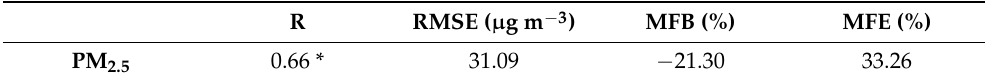
Table 4. Statistical metrics of the comparisons from hourly observed and simulated surface PM 2.5 concentrations at 11 typical sites during 24–26 March 2017. The “*” indicates R passed the 99.9% confidence level.